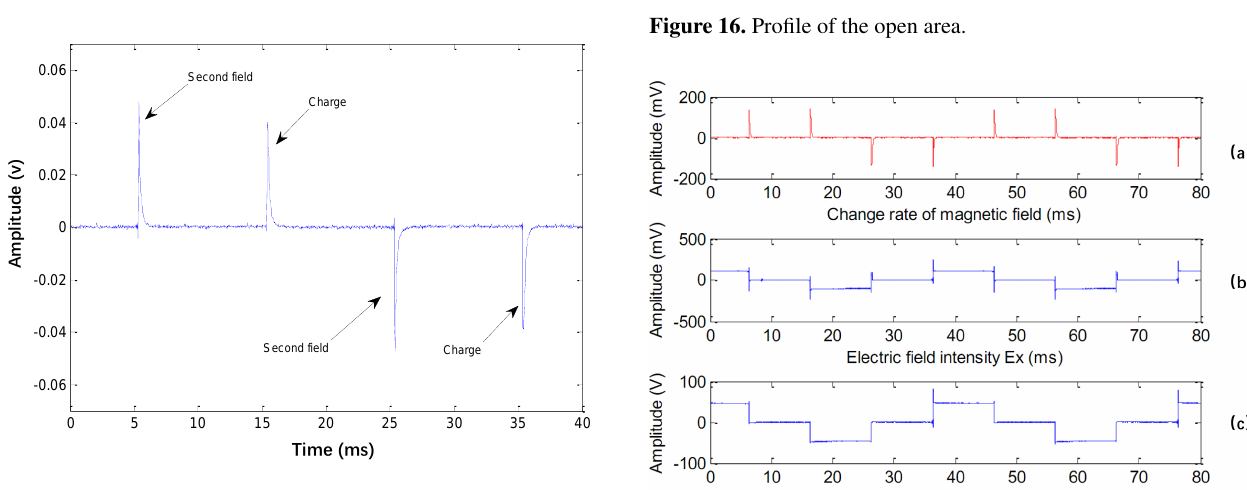
Figure 15. Single cycle waveform (40ms).